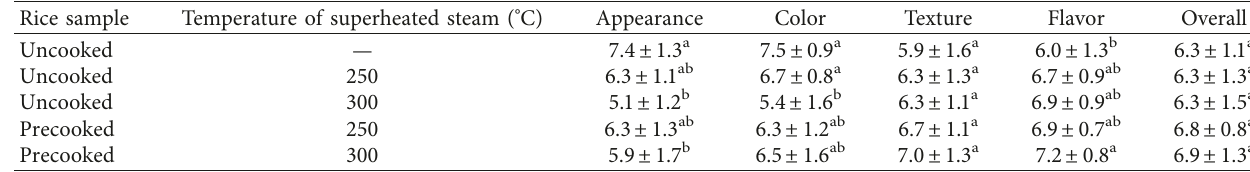
Table 5: Liking scores of cooked black glutinous rice with/without superheated steam